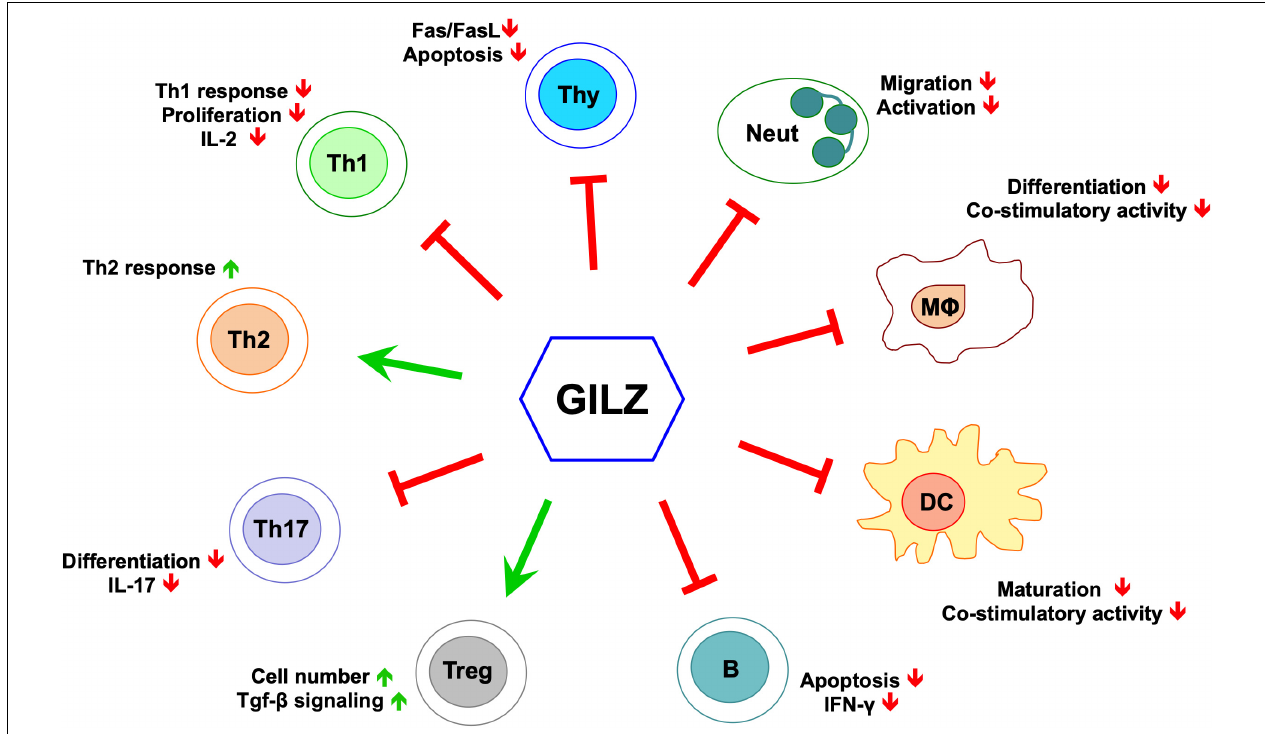
FIGURE 1 | GILZ’s effects in cells of the immune system. Green arrows indicate positive regulation, red lines indicate negative regulation. Neut, neutrophils; M φ , monocytes/macrophages; DC, dendritic cells; B, B cells; Treg, T regulatory cells; Th17, T helper Type-17 cells; Th2, T helper Type-2 cells; Th1, T helper Type-1 cells; Thy,